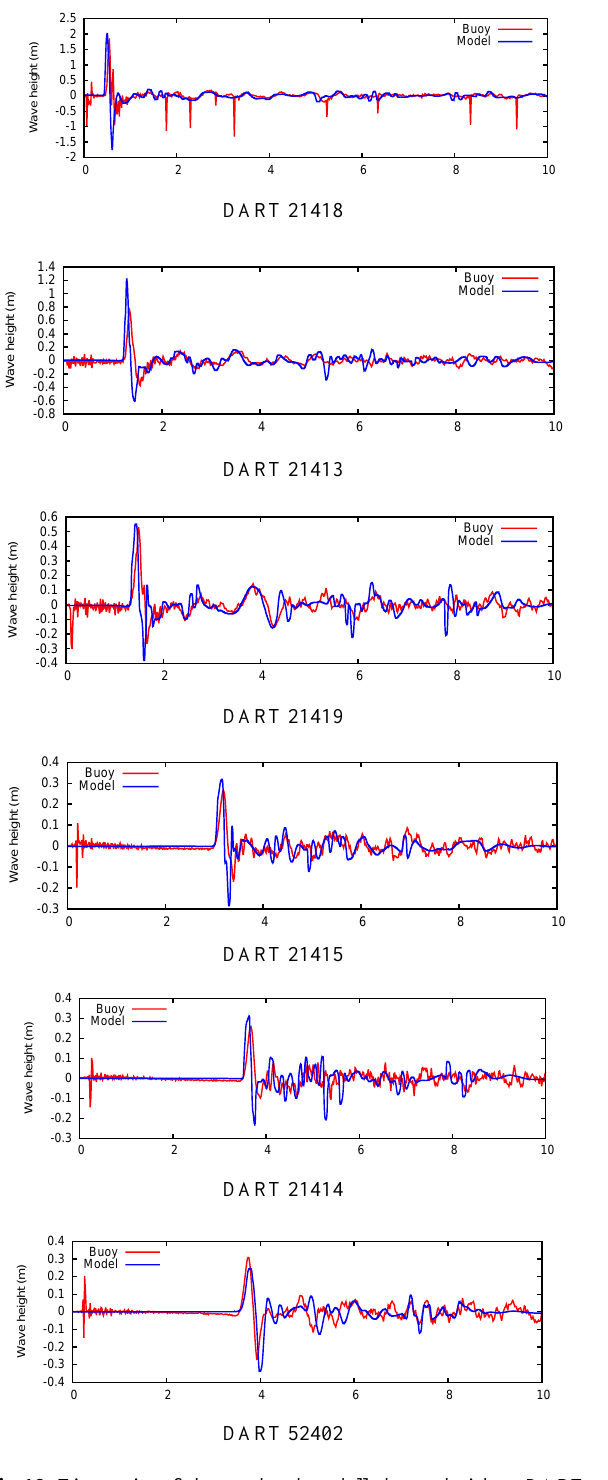
Fig. 12. Timeseries of observed and modelled wave height at DART buoys locations, ordered by increasing arrival time from top to bot- tom. Horizontal axis is time in hours.